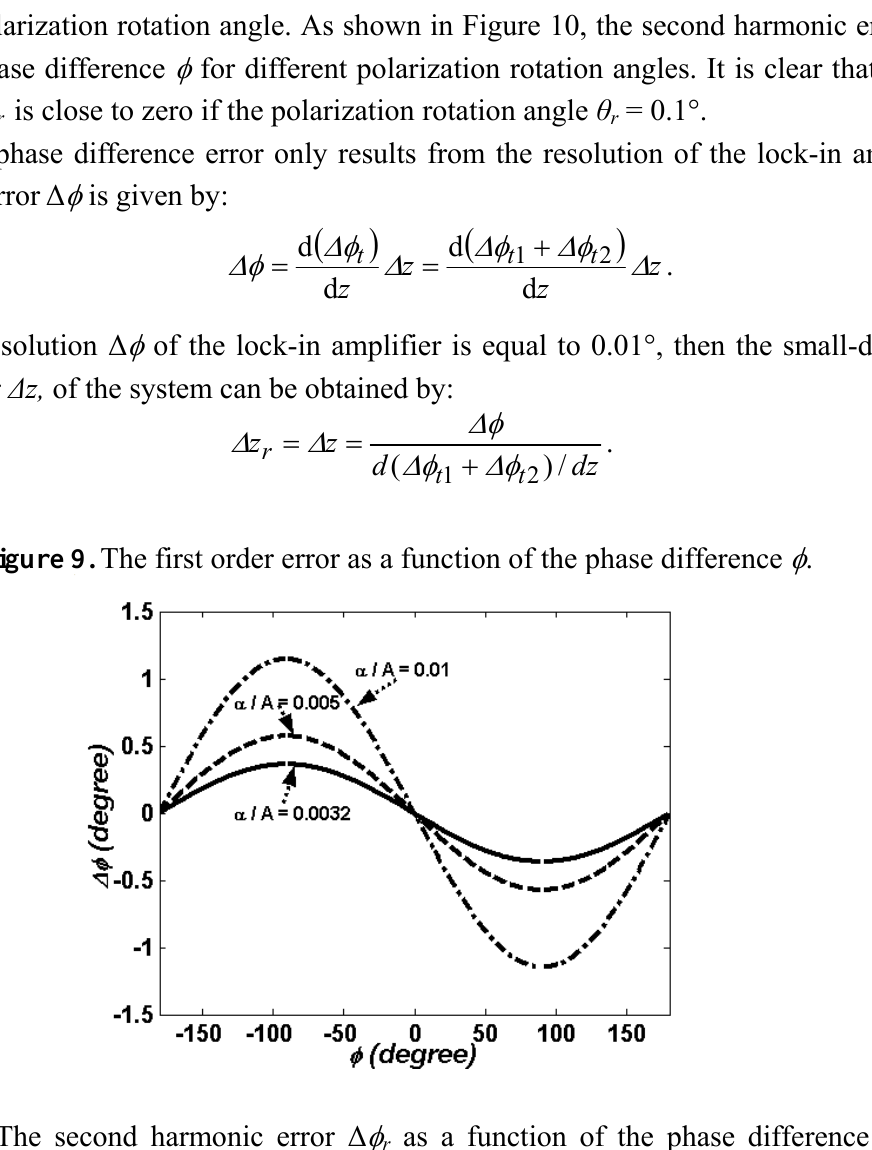
as a function of the phase difference  for r